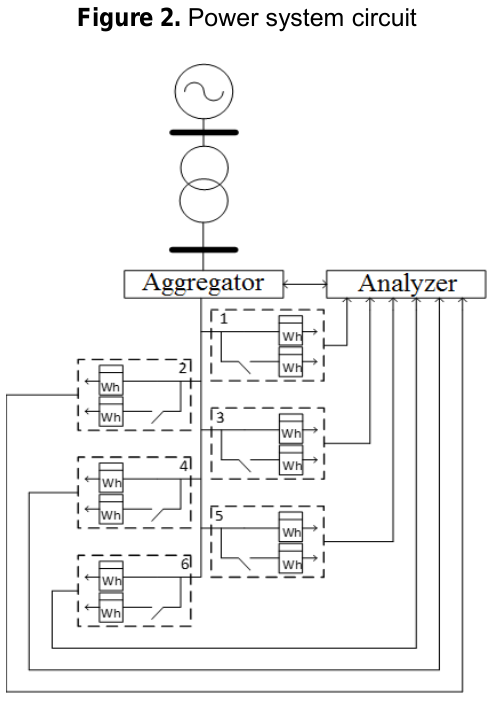
Figure 3. Changed power system